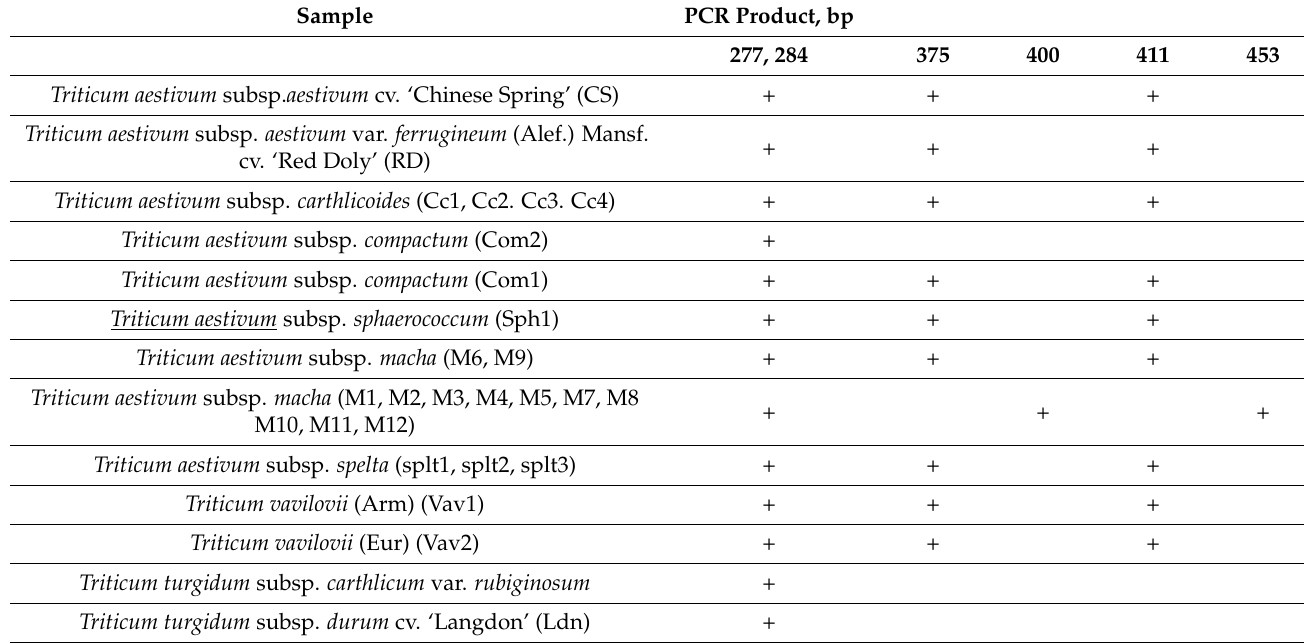
Table 7. PCR-based haplotype analysis of the fourth intron of Wknox1d . A 122-bp MITE insertion specifically observed at the D-genome locus of Wknox1 generates the upper bands (411 bp) in hexaploid wheat accessions (except Triticum aestivum L. subsp. compactum ) and 453 bp in macha